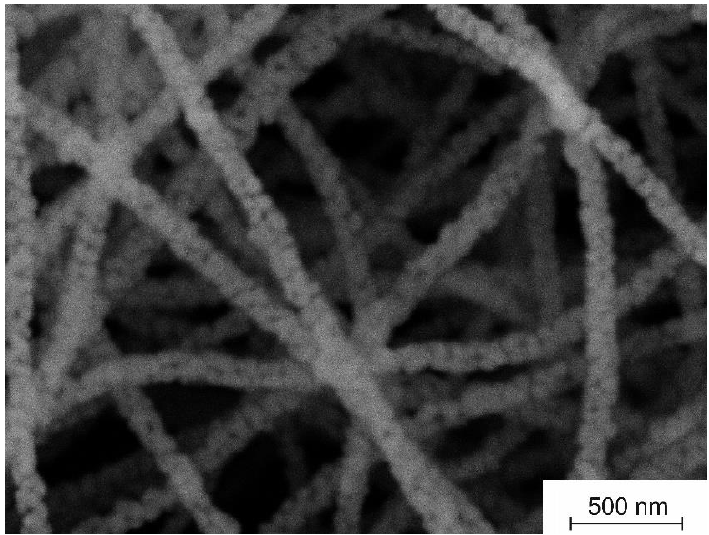
Figure 3. The microstructure of electrospun CaAA/PAN fibers annealed at 800 °C. It can be clearly seen in Figure 3 that the fabricated nanofibers are porous. The pores of arbitrary size are located at the junctions of adjacent CaO grains. The nitrogen adsorption measurements indicate that the specific surface area and the specific pore volume of CaO nanofibers are 31 m 2 /g and 0.051 cm 3 /g, respectively. Previously, zirconia nanofibers with the average diameter of about 100 nm and close values of specific sur- face area and specific pore volume were fabricated from the electrospun composite fila- ments containing zirconia acetylacetonate and polyacrylonitrile [27]. According to the performed DTG analysis, CaO nanofibers most intensively sorb CO 2 in the temperature range of 610 – 633 °C, which is determined by the carbona- tion-rate peak width at half height (Figure 4). The carbonation rate attains the maximum value at 618 °C. Therefore, the given temperature was chosen as the carbonation tem- perature. Figure 4. The DTG curves of CaO nanofibers carbonation and decarbonation processes.